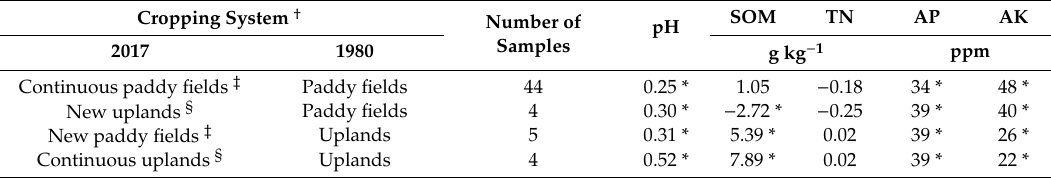
Table 4. Changes in quantified soil attributes between 1980 and